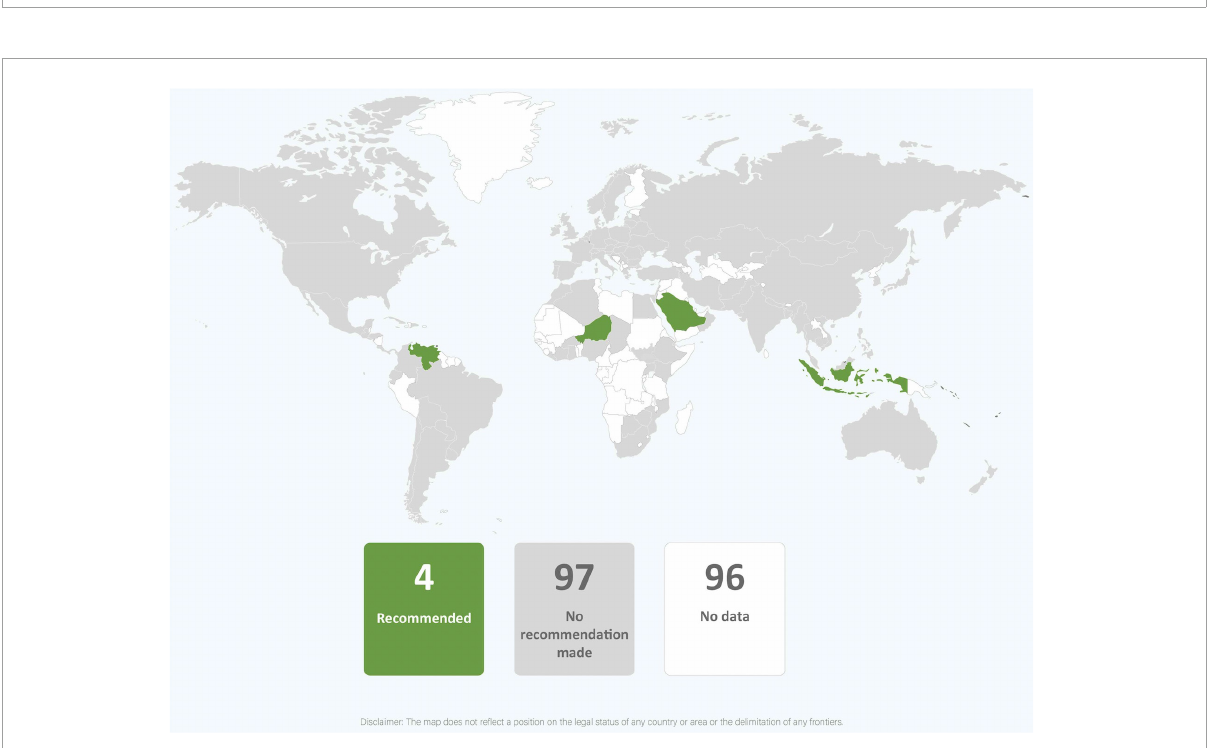
FIGURE11 Global distribution of recommendations on wet nursing infants of mothers with COVID-19 (data from 101